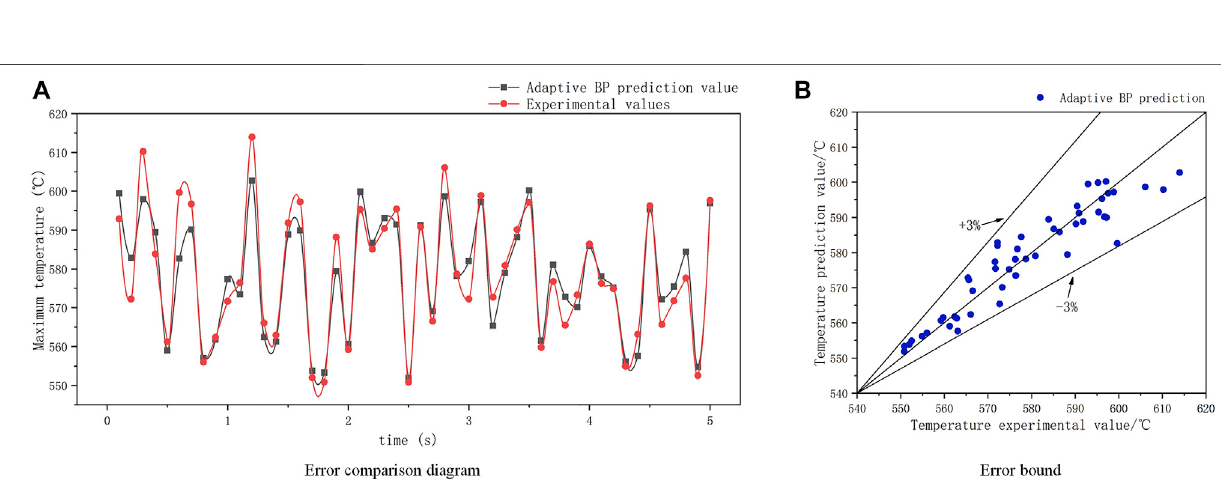
FIGURE 8 | The error comparison diagram and the error bound of adaptive BP neural network under coolant mass fl ow variation condition.